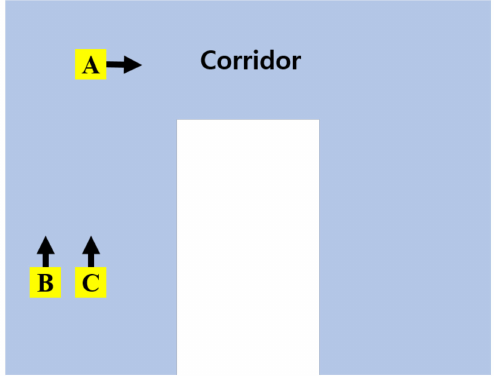
Figure 14. Robot’s location and direction ( A–C ) in the corridor drawing.